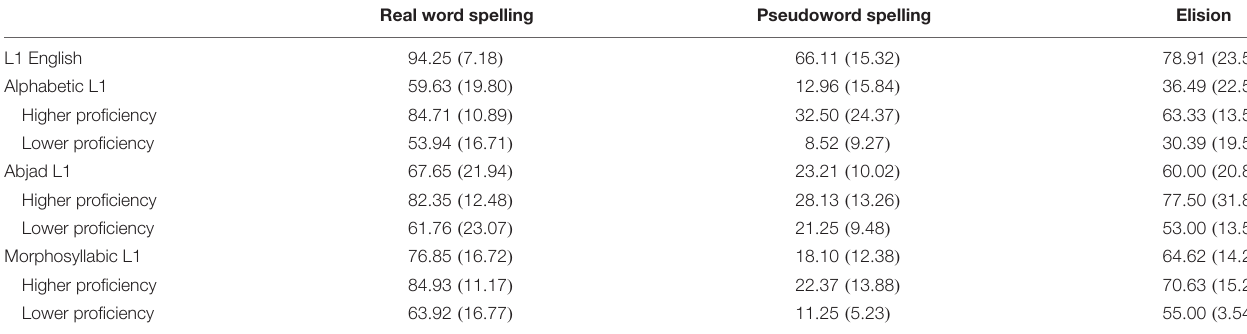
TABLE 3 | Mean word and pseudoword spelling accuracy and elision accuracy (% correct) by L1 background and ESL proficiency